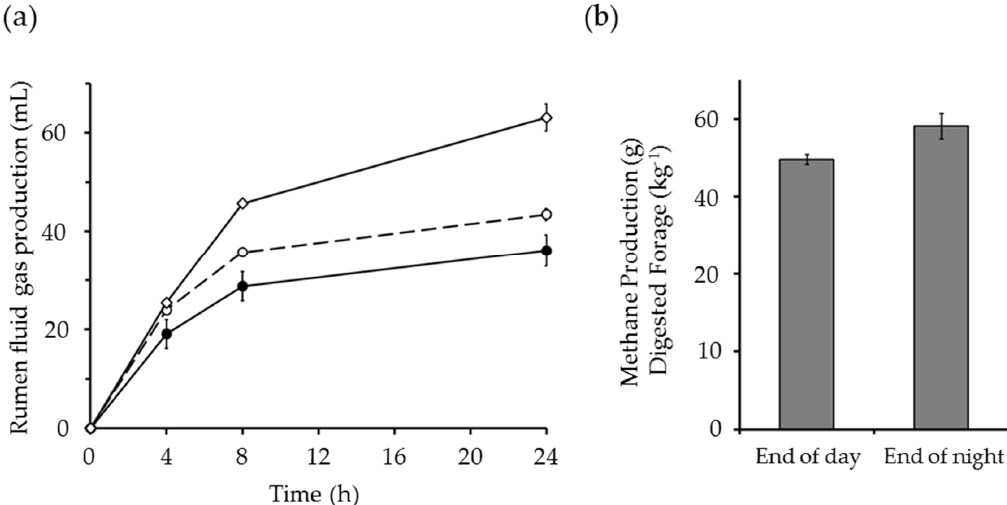
Figure 6. Diurnal starch accumulation increases the digestibility of red clover. The same tissue that was analyzed in Figure 3a for genotype TpDST20 was analyzed by the Hohenheim gas test. ( a ) Gas production from rumen fluid digestion of TpDST20 samples harvested at the ED (empty circles), or the EN (filled circles). Gas production from the Hohenheim concentrate standard is presented as a reference (empty diamonds); ( b ) Methane production from ED and EN samples from Figure 6a after 24 h of digestion. Error bars represent 95% confidence intervals ( N = 5). Details are described in Supplementary Methods.